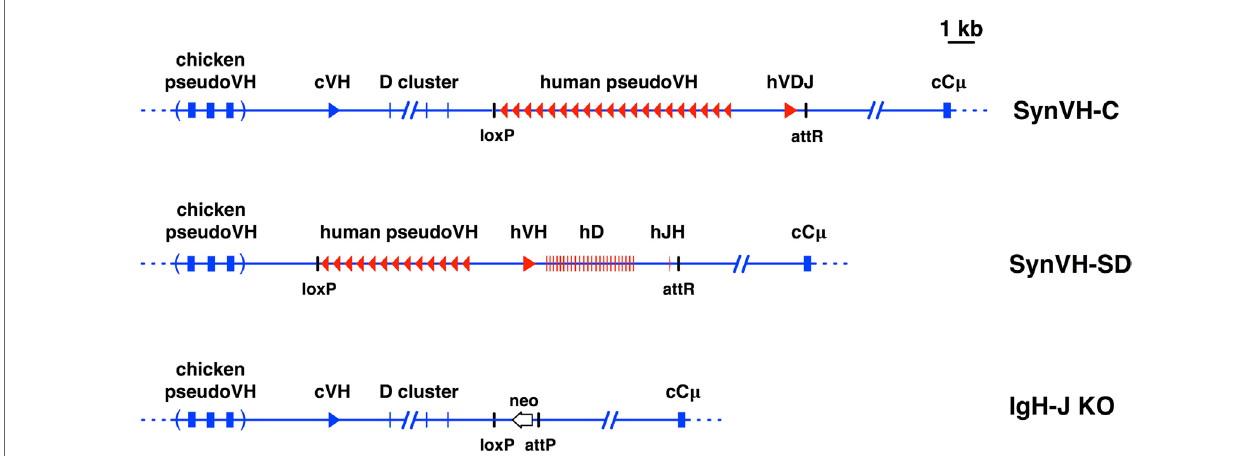
FigUre 1 | Diagrams of pre-rearranged and rearranging human VH genes in the chicken. Scale diagrams of SynVH-C (pre-rearranged) and SynVH-SD (rearranging) transgenes and the heavy chain knockout (IgH-J KO). Human sequences are shown in red and chicken in blue. Top line, the SynVH-C transgene consists of a pre-rearranged human V region (hVDJ) with an upstream array of human pseudogenes. This diagram was previously published (18). The human V region splices to the downstream chicken constant regions (only C μ is shown). The chicken germline V and D genes, and pseudogene array, are upstream of the human V genes. Precise mapping of chicken pseudogenes is not shown (as indicated by parentheses), but the distance to the functional chicken V is accurate. Remnant loxP and attR sites from the insertion event are shown. Middle line, the SynVH-SD transgene contains a single human germline VH3-23 gene, single JH6 gene, and 24 unique human Ds. All intervening sequences and recombination sites are from the chicken heavy chain locus (shown in blue). Upstream of the human germline V gene is an array of human-based pseudogenes. The upstream chicken germline V and D genes are deleted, but the chicken pseudogenes are still present. Bottom line, structure of the chicken heavy chain knockout (21). The genotype of the OmniChickens in this study was SynVH-C or SD “knock-in”/IgH knockout. The single chicken JH gene was replaced with a promoterless neo gene. The attP site adjacent to the neo gene is where the SynVH-C and SynVH-SD constructs were inserted, followed by Cre-lox recombination to remove selectable markers and plasmid backbone